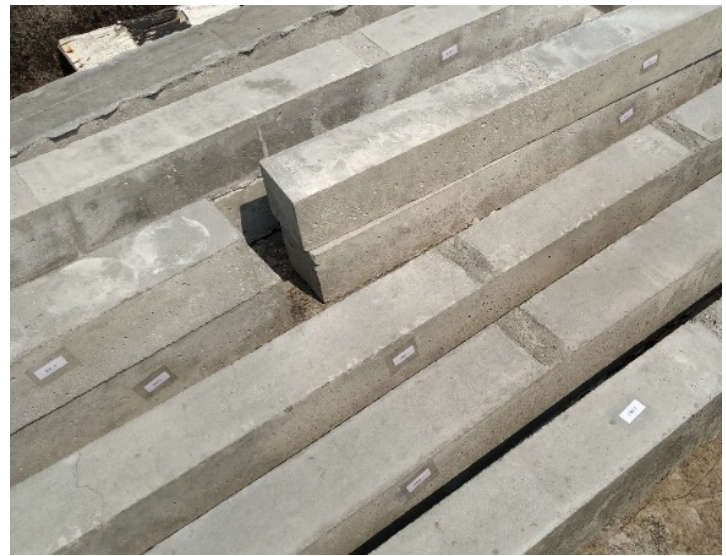
Figure 6. Structural elements.